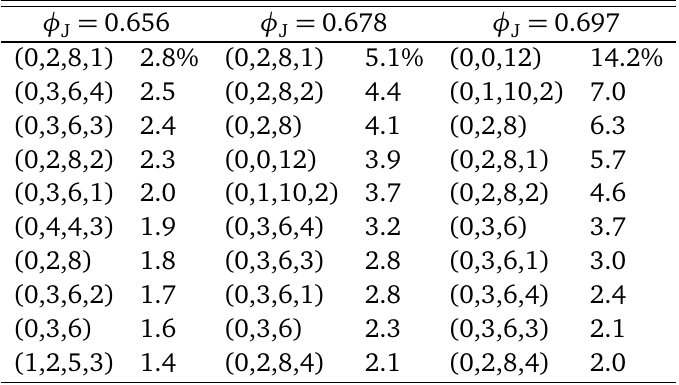
= 0.500 fluid of icosahedral structures for both fluid and jammed 0,0,12 ) and of φ . We J fluid